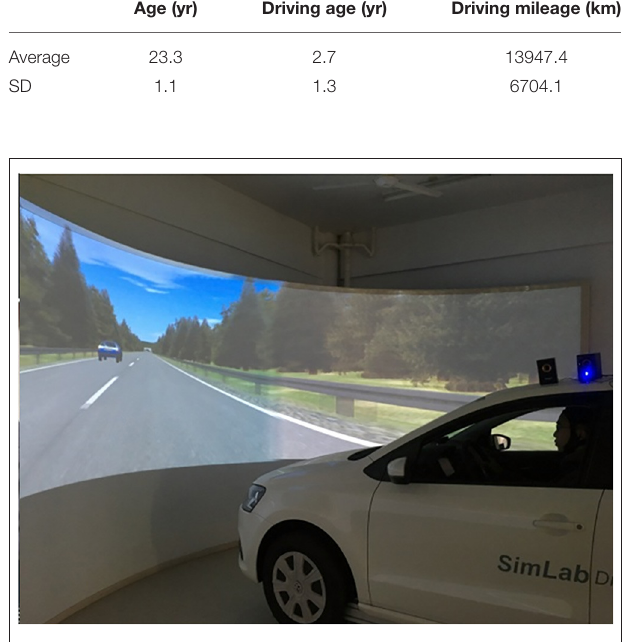
FIGURE 2 | Subject in SimLab driving